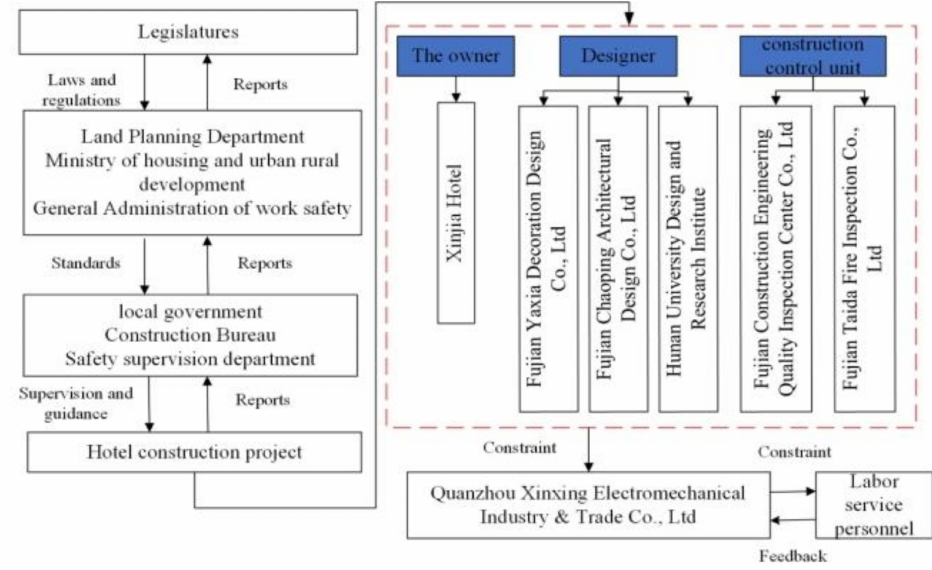
Figure 7. Safety control structure chart of the Xinjia Hotel construction